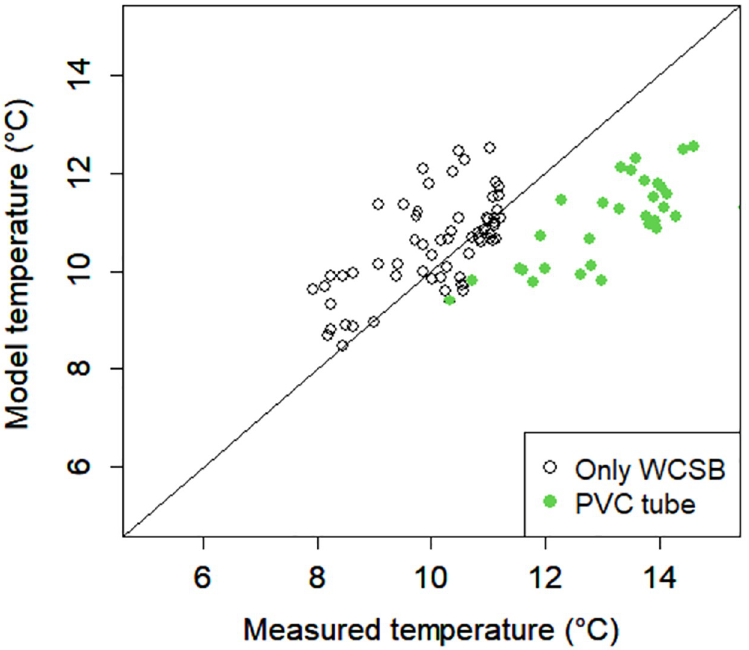
Fig 10. Accuracy test of the heat budget model that estimated WCSB temperature. Root mean square error, bias, and determination coefficient were 1.52˚C, –0.39˚C, and 0.341, respectively.